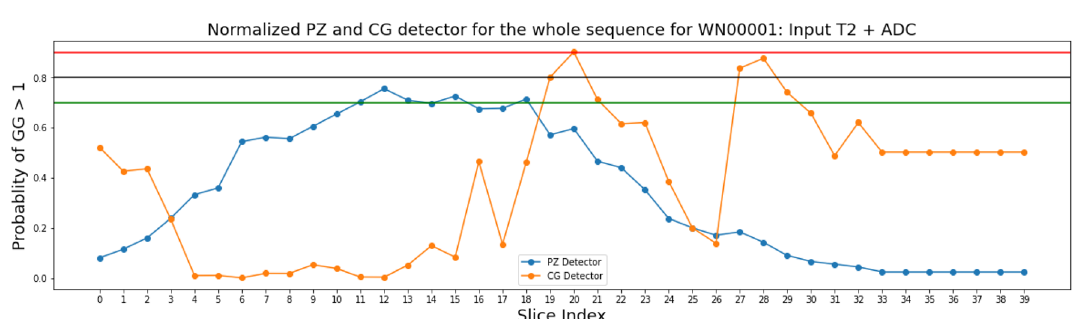
Figure 6. Grad-cam for PZ (left) and CG (right) respectively, showing the attention of the model aligned well with the lesion if malignant.